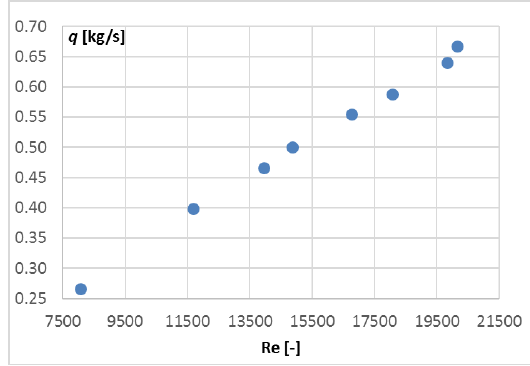
Fig. 2. Flow values q as a function of the Reynolds number.